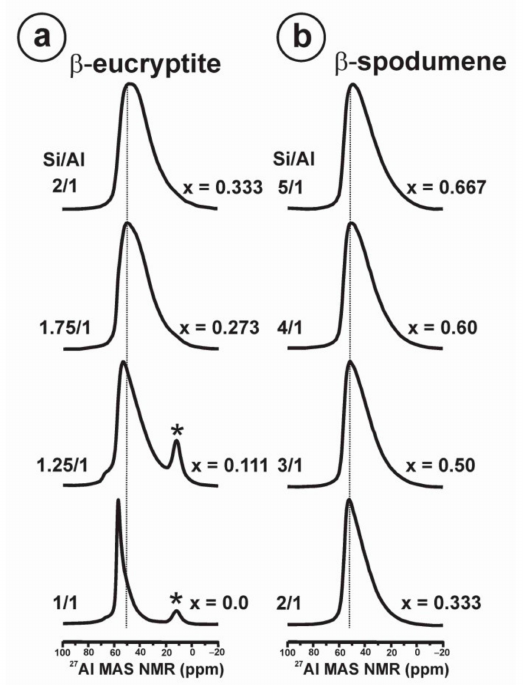
Figure 7. The 27 Al MAS NMR spectra of β -eucryptite ( a ) and β -spodumene ( b ), for several x values in Li 1 − x Al 1 − x Si 1+x O 4 along the solid solutions. The signal of octahedral aluminum from σ -Al 2 O 3 is marked with an asterisk * in the samples with nominal x values of 0.0 and